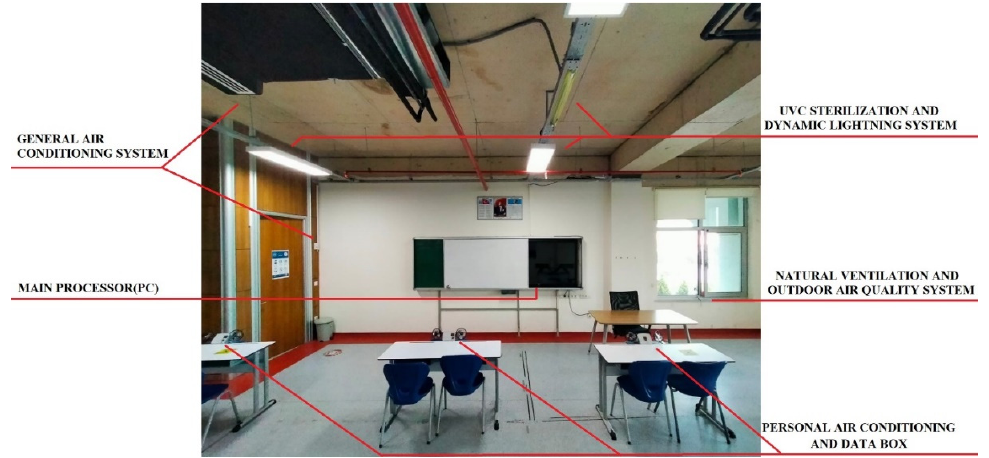
Figure 4. Dimensions (cm) and geographical position of the SCI .